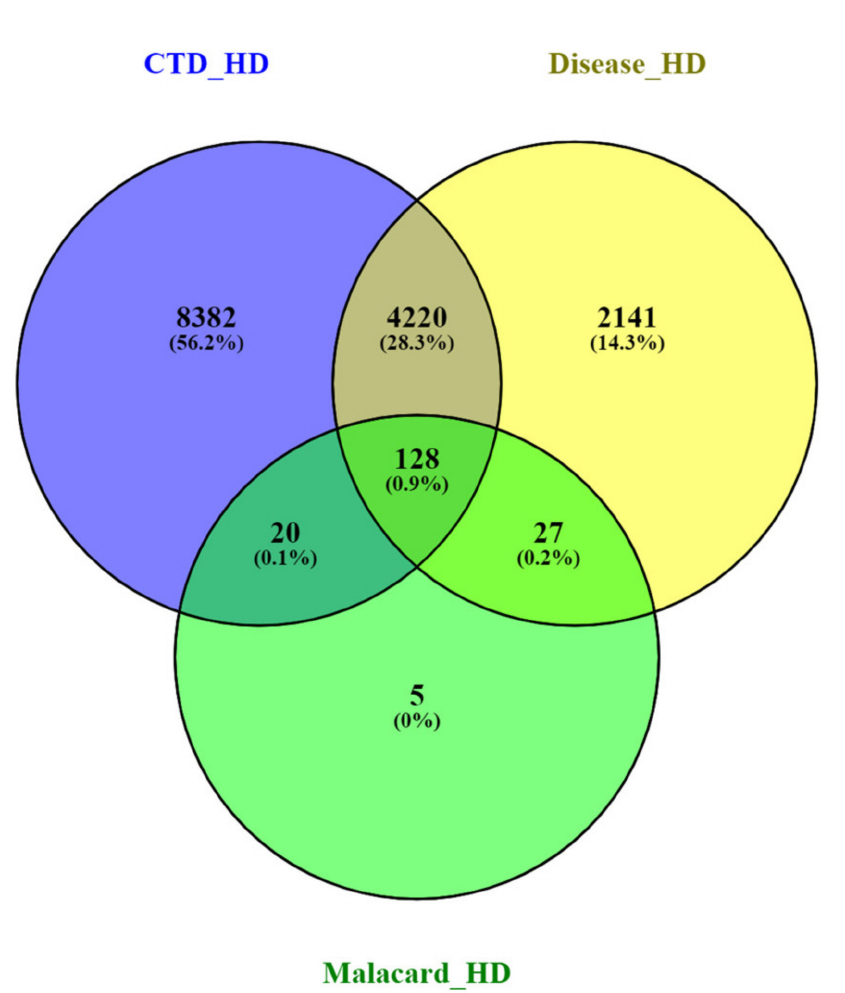
Figure 8. Venn diagram representing the common and exclusive gene targets of the HD CTD, Disease and Malacards